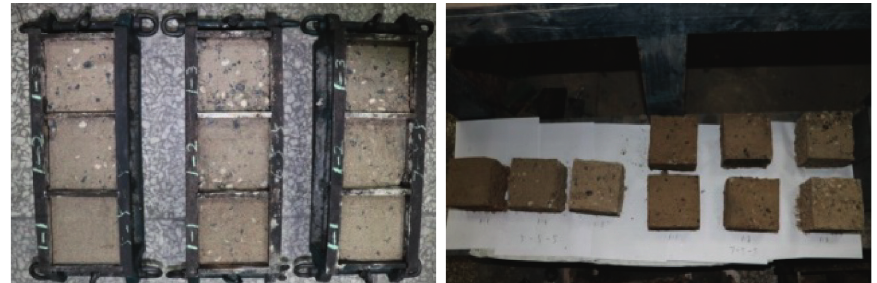
Figure 5: Test block of different proportions.